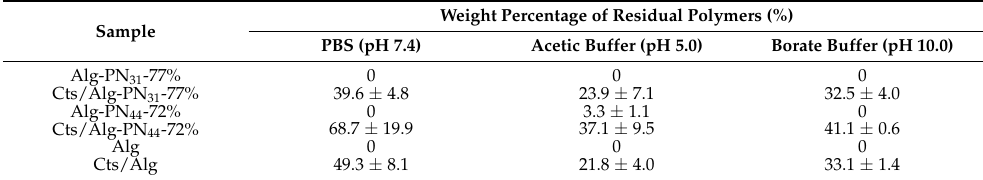
Figure 5. Cumulative release of rhodamine B from the hydrogel samples Alg-PN 31 -77%, Cts/Alg- PN 31 -77%, Alg-PN 44 -72%, Cts/Alg-PN 44 -72%, Alg, and Cts/Alg in PBS buffer (pH 7.4) at 37 °C. Table 3. The weight percentage of residual polymers after 100% release of RB in PBS buffer (pH 7.4), acetic buffer (pH 5.0), and borate buffer (pH 10.0).